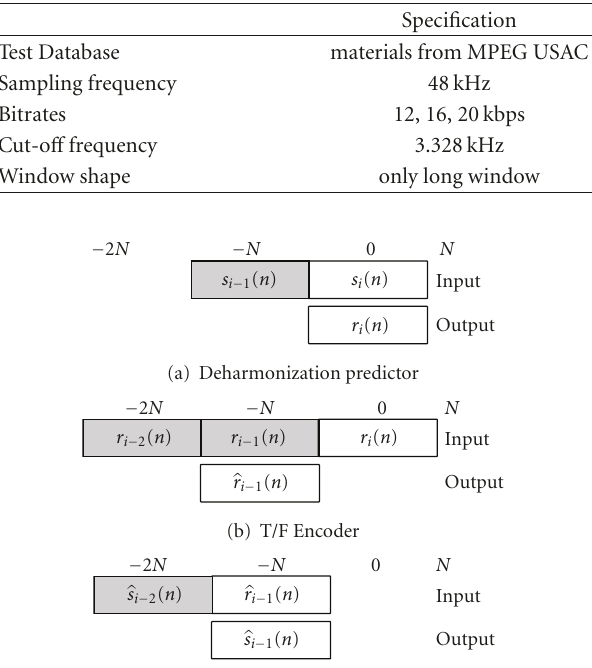
shown in Figure 6(a). Then the synthesized signal, (cid:6) s i − 1 ( n ),